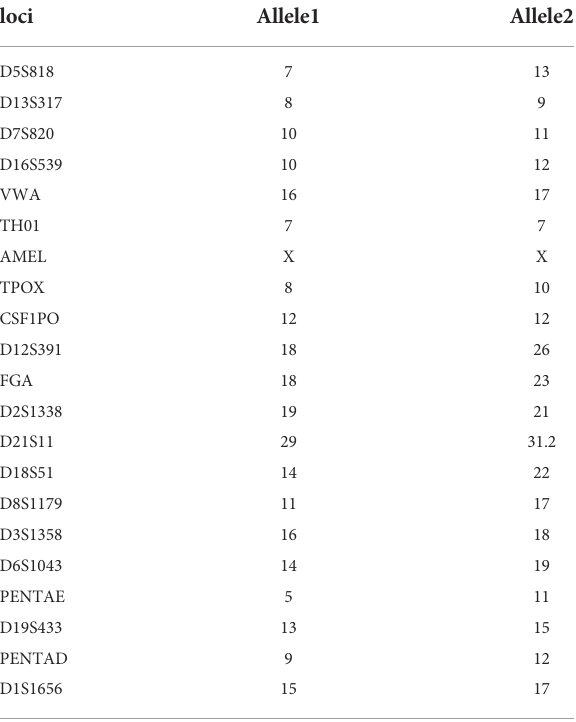
TABLE 1 STR authentication in L-2F7 cells. loci